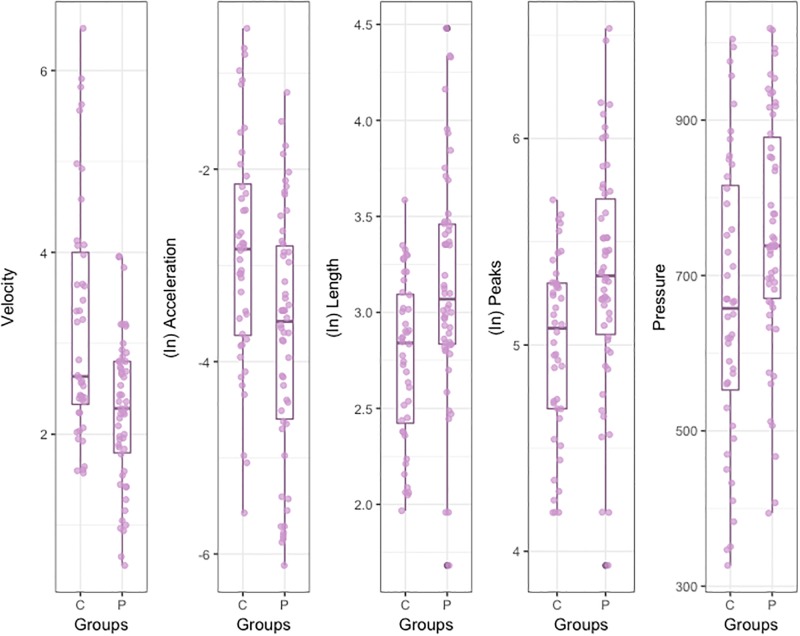
Box Plot for handwriting variables.